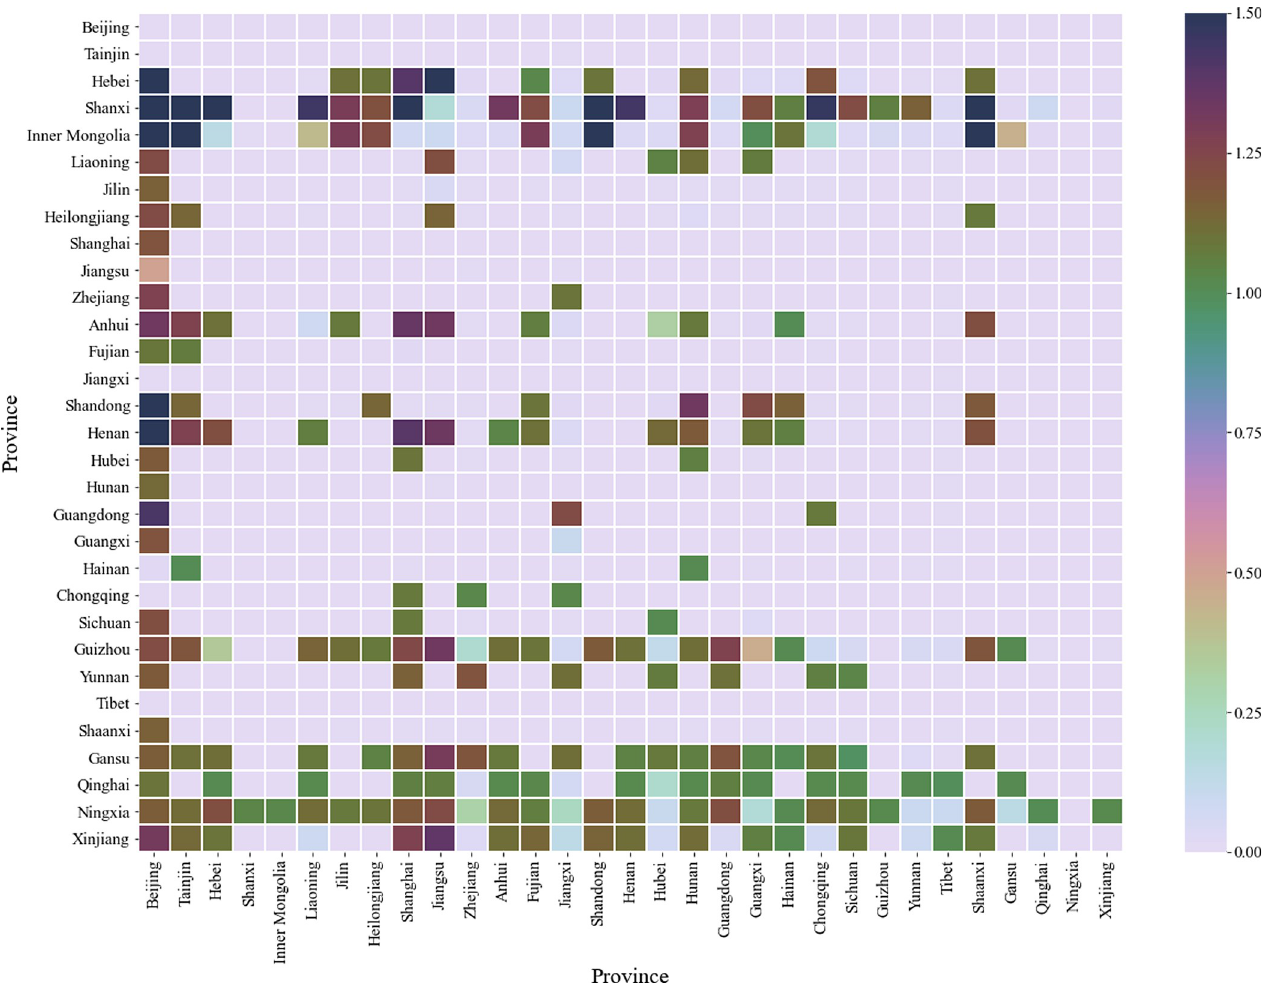
Fig 3. The matching degree of embodied carbon trade and value-added trade among 31 provinces in China in